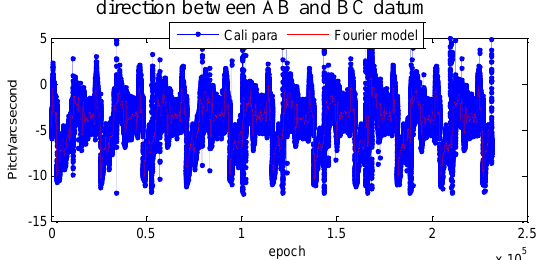
Figure 8. Chart of conversion parameters variation in roll direction between internal and earth observation camera datum